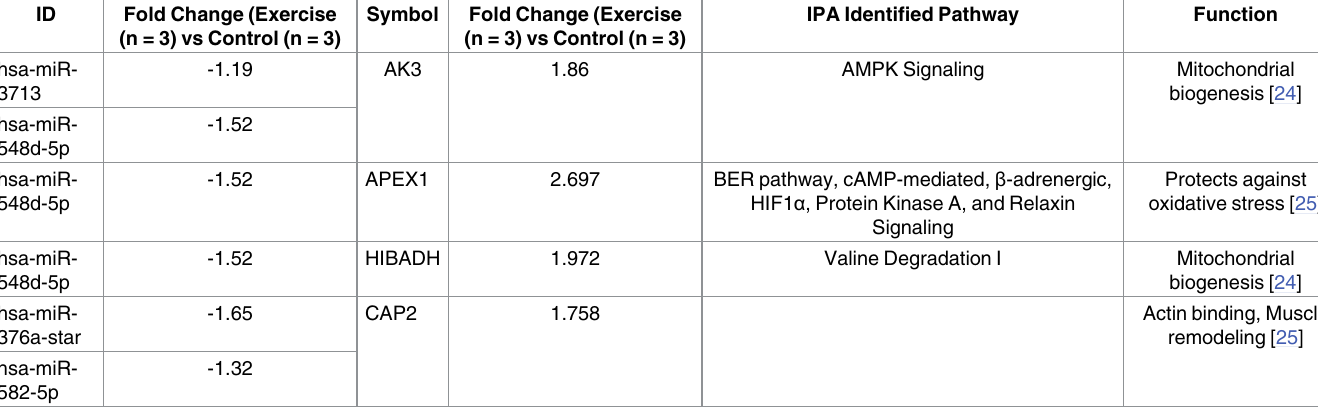
Table 4. Pathway analysis of expression-paired microRNA-protein alterations in exercisedpatients. ID Fold Change (Exercise (n = 3) vs Control (n =